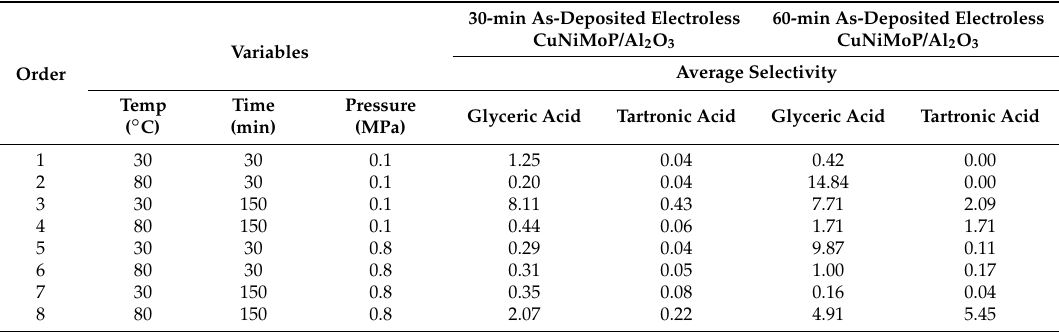
Table 6. Selectivities of glyceric and tartronic acids for both catalysts.